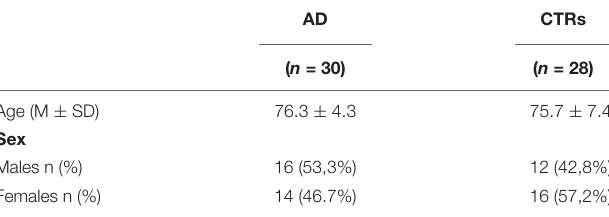
Values are reported as average ± standard deviation. The percentage of male and female subjects is also